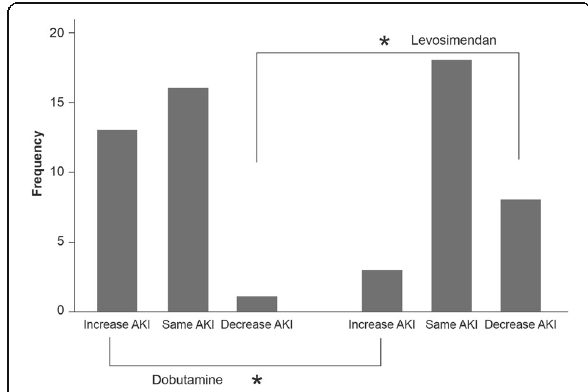
Fig. 5 Variation of acute kidney injury (AKI) stage after 48 h in patients treated with dobutamine vs levosimendan. *Statistically significant difference. Figure drawn freely from the data reported by Guerrero-Orriach et al.